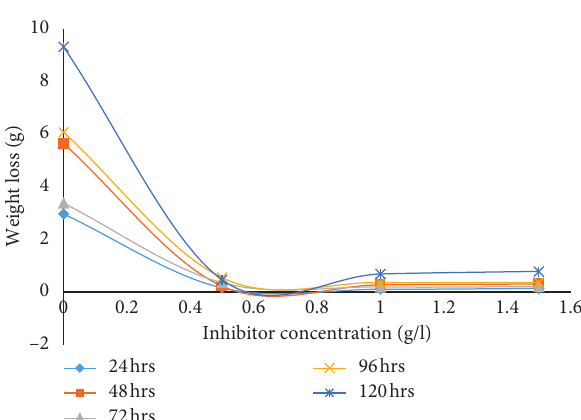
2 SO 4 Figure 3: Corrosion rate (mm/yr) of mild steel in dilute H with variation in inhibitor concentration (g/l) at various immersion times.